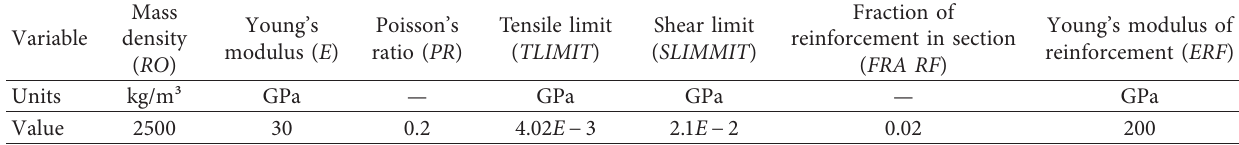
Table 3: Material parameters of the reinforced concrete.